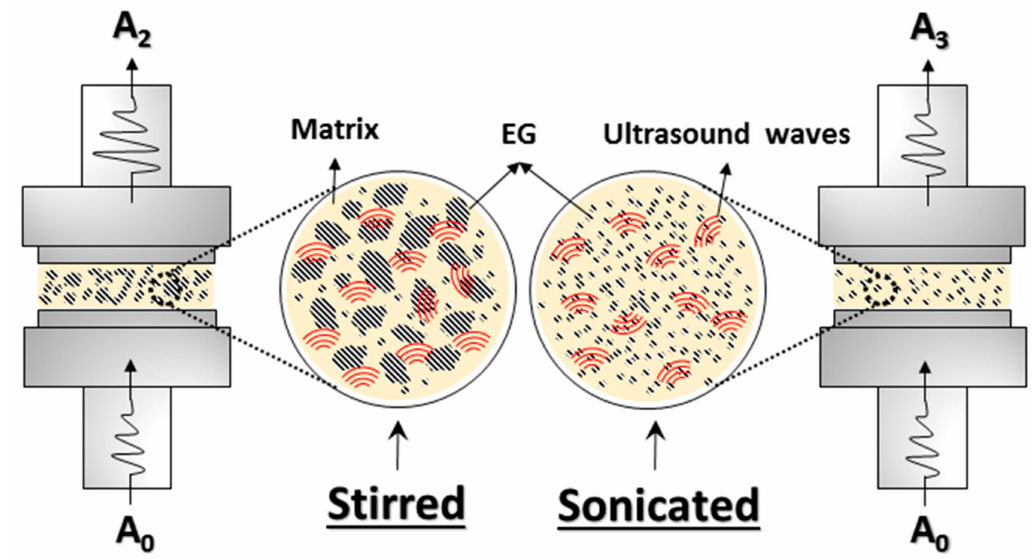
Figure 12. Schematic representation of ultrasonic dynamic mechanical analysis (UDMA) measurements in stirred and sonicated